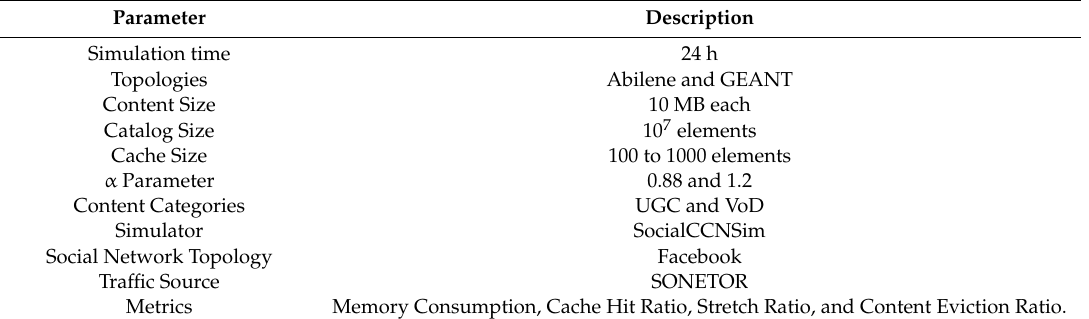
Table 1. Simulation